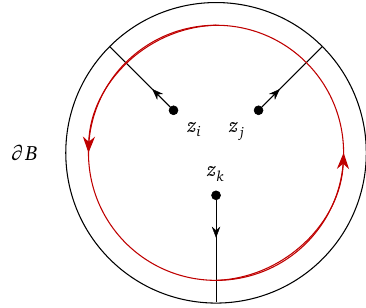
Figure 7: The figure shows three points z erates. An oriented branch cut emanates from each of these and terminates on the boundary. The topology of X is determined from the total monodromy picked up along the red